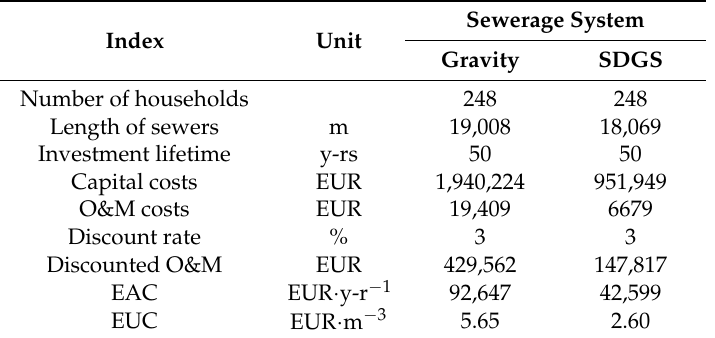
Table 5. Cost–effectiveness analysis for two alternatives of the sewerage system—gravity and SDGS—system for the Zolkiewka commune.